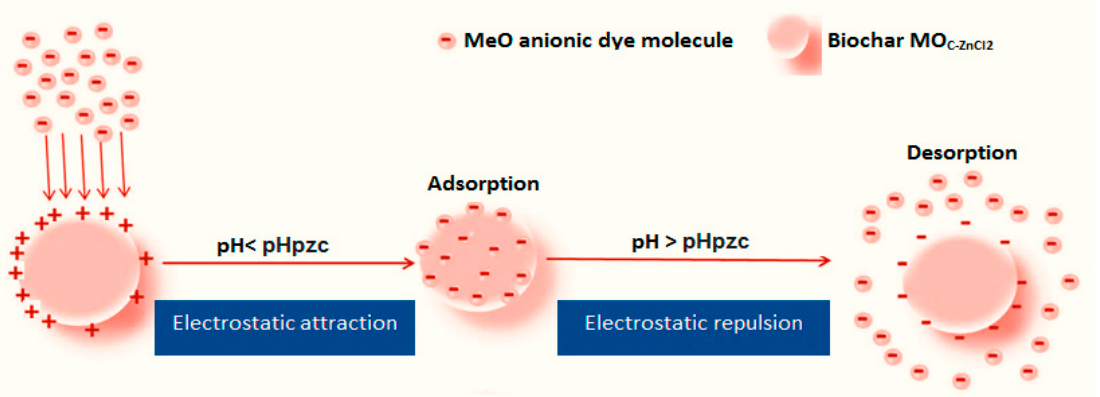
Figure 7. Schematic representation for adsorption and desorption of MeO anionic dye onto MO C-ZnCl2 nanoporous carbon.